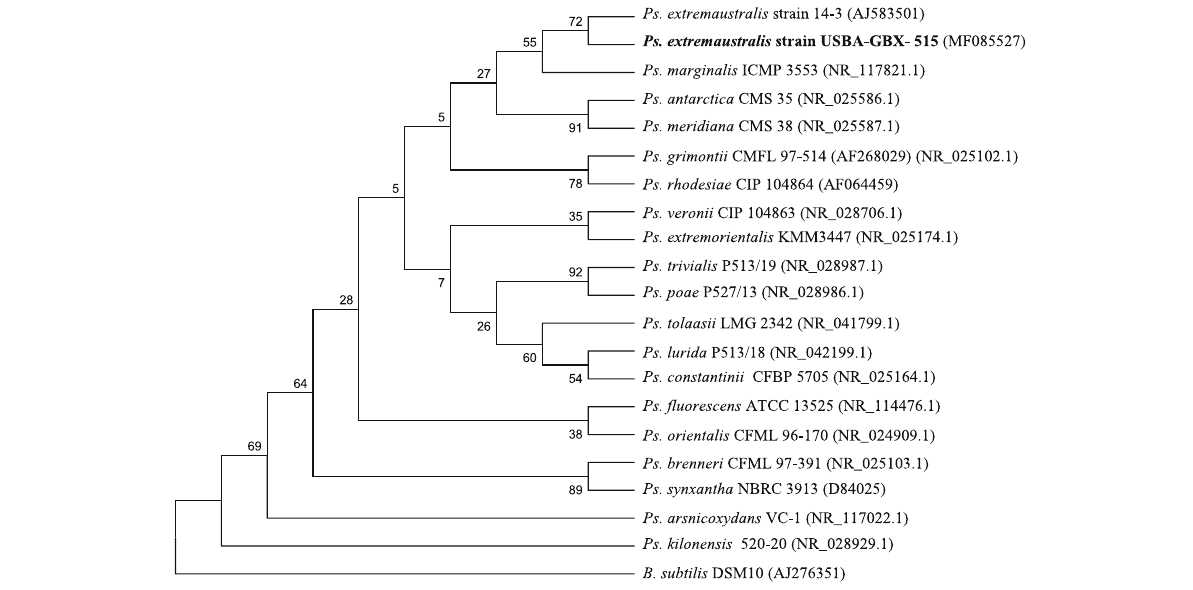
Fig. 2 Phylogenetic tree based on 16S rRNA gene sequences showing the phylogenetic position of Pseudomonas extremaustralis USBA-GBX-515. Bootstrap values were based on 1000 resamplings. Sequence accession numbers are given in parentheses